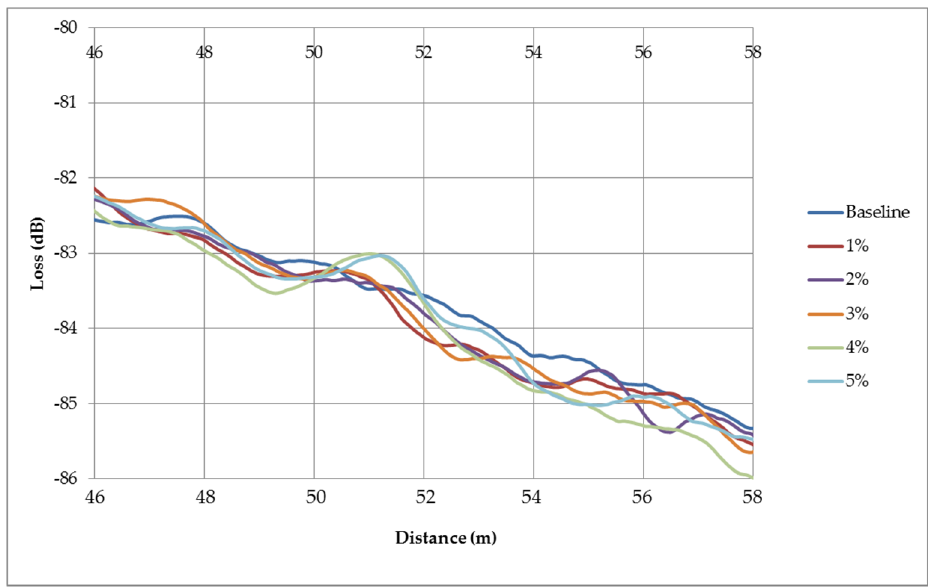
Figure 18. OTDR signal at low strain intervals from 1% to 5% strain.